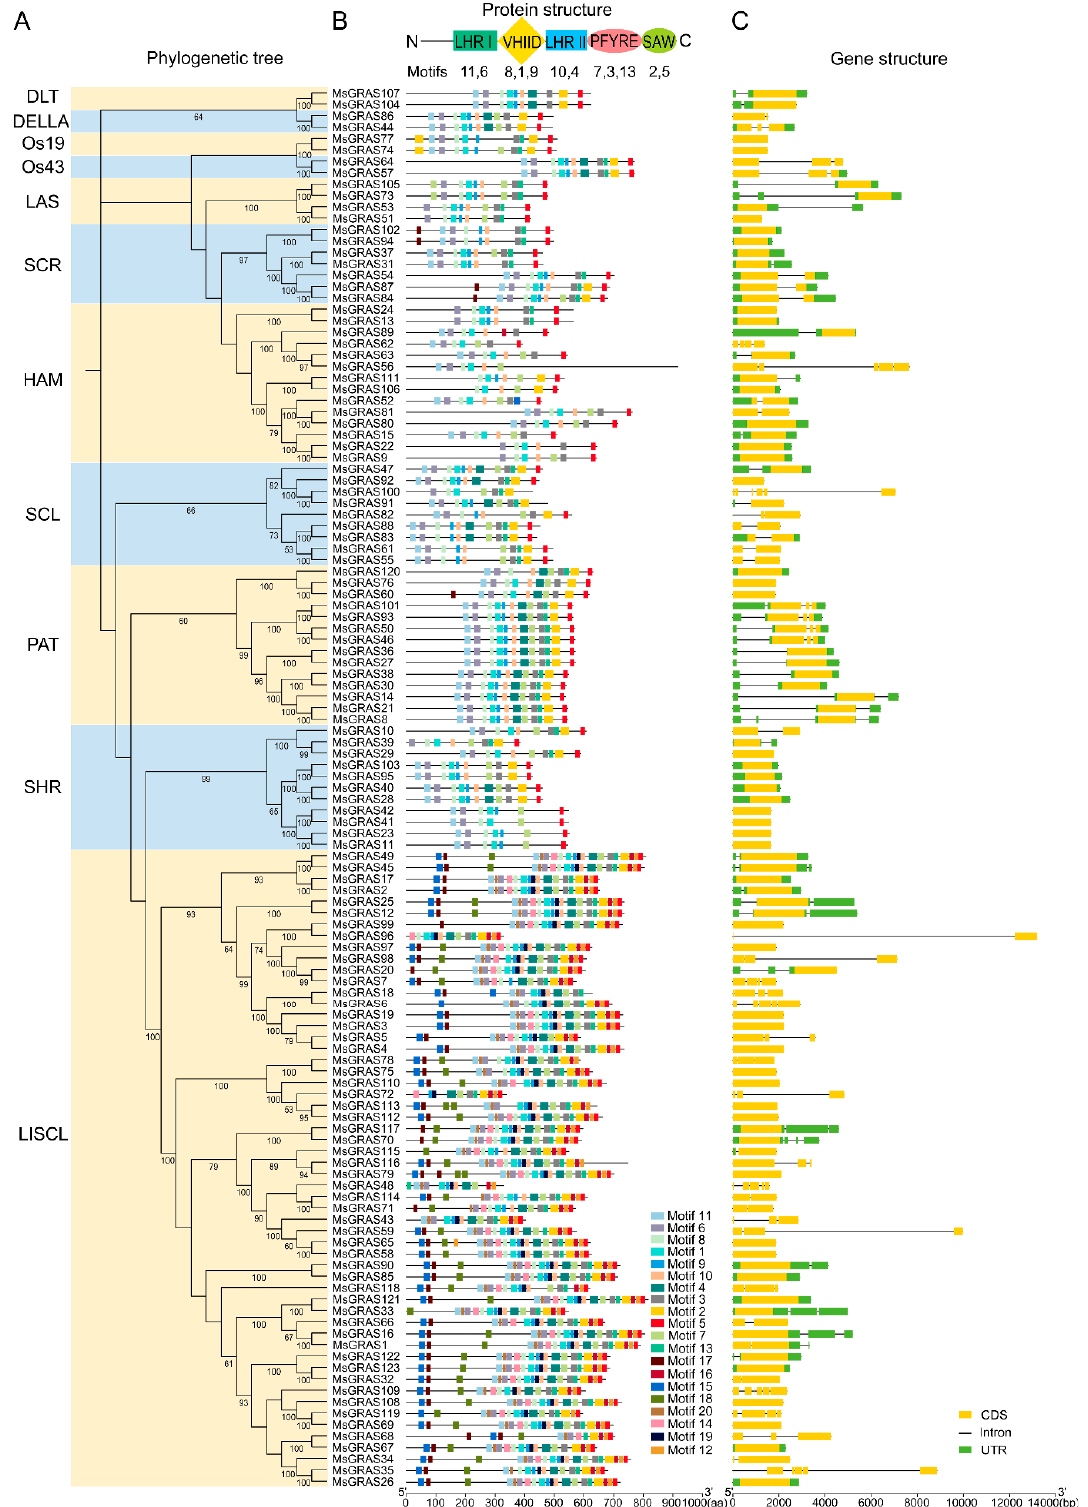
Figure 3. Phylogenetic relationship, motif distribution, and gene structure of MsGRAS. ( A ) Phylo- genetic tree constructed based on the alignments of 123 MsGRAS full-length amino acid sequences. Bootstrap values higher than 50% are shown. ( B ) Conserved motifs in MsGRAS proteins. Each motif is shaded with colored boxes. ( C ) Gene structure of MsGRAS . Un-translated region (UTR), exons, and introns are indicated by green rectangles and yellow and black lines,